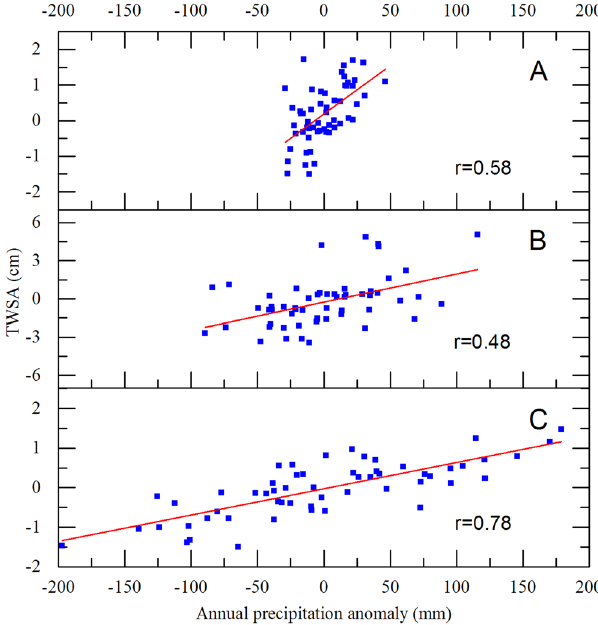
Figure 6. The correlation between the annual precipitation anomaly and TWSA of each sub-region ( A,B and C ). The red line is the simple linear regression fitting line ( p < 0.01). This result was performed using Origin 9.0